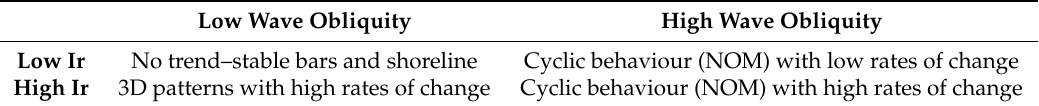
Table 7. Schematic of the roles of beach slope and wave obliquity on the bars-shoreline system evolution. Low Wave Obliquity High Wave Obliquity Low